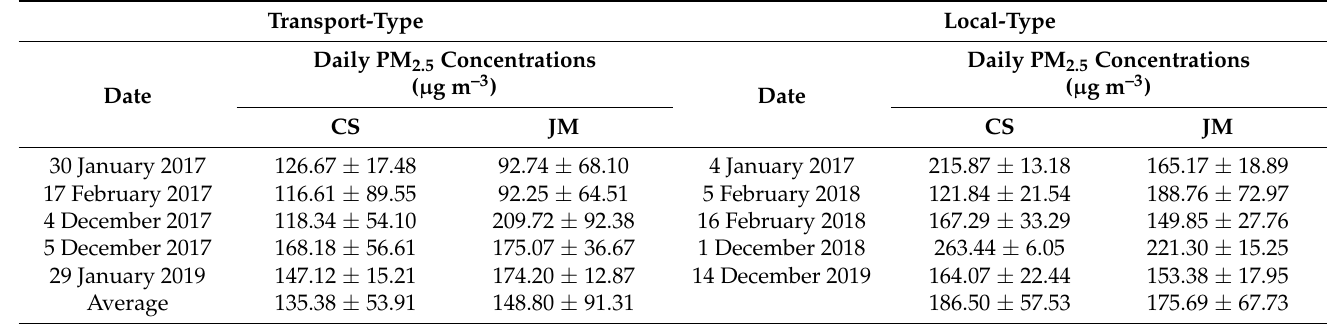
Table 4. Daily PM 2.5 concentrations and wind speed (expressed as mean ± standard deviation) in typical transport-type and local-type heavy PM 2.5 pollution days in CS and